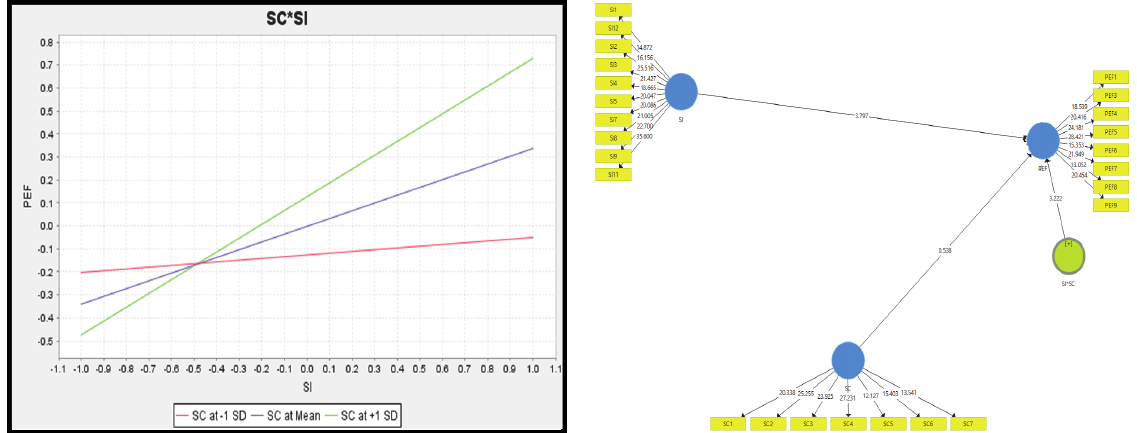
Fig. 5. Structure Capital Moderation Algorithm